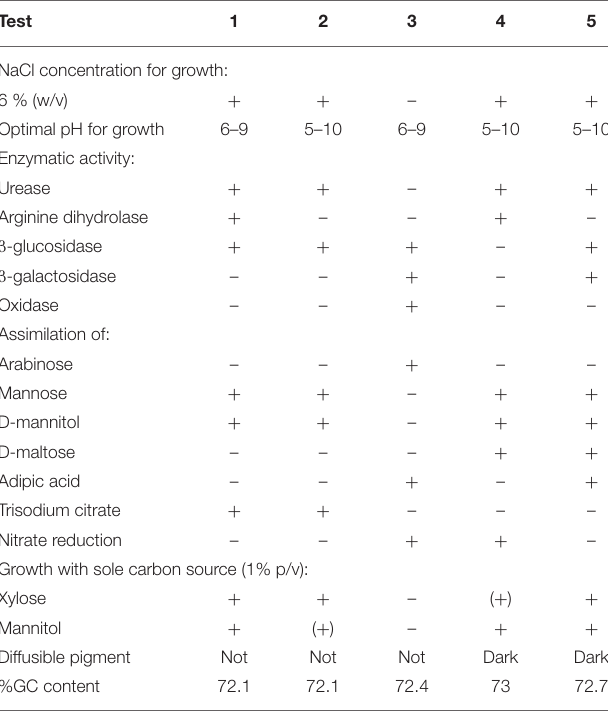
TABLE 1 | Differential characteristics of strains MZ03-37 T , MZ03-48, and related